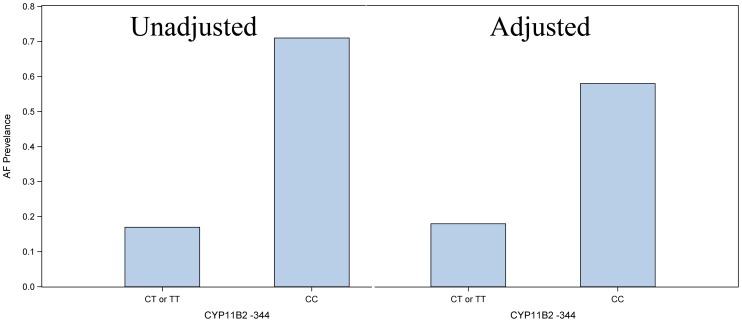
Unadjusted and adjusted (marginal standardization) proportions of individuals among CYP11B2−344T>C genotype groups with AF.